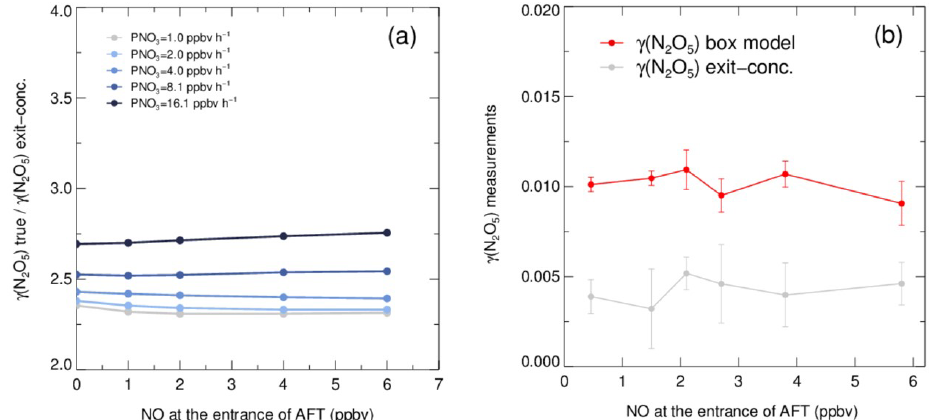
Figure 6. Simulated and laboratory tests on the performance of the box model method and exit concentration method for γ( N 2 O 5 ) derivation. (a) The ratios of given γ( N 2 O 5 ) ( γ( N 2 O 5 ) true) over exit concentration-derived γ( N 2 O 5 ) ( γ( N 2 O 5 ) exit conc.) determined from simulated scenarios. The γ( N 2 O 5 ) derived by the box model method is exactly the same as γ( N 2 O 5 ) true. The ratios vary with NO concentration, and the lines are color coded by PNO 3 values. Both NO concentration and PNO 3 represent the values at the entrance of the aerosol flow tube. (b) γ( N 2 O 5 ) measurements on laboratory-generated (NH 4 ) 2 SO 4 aerosols under different gradients of NO with a constant RH of 50% and PNO 3 typically generated from our N 2 O 5 source. The red line shows the γ( N 2 O 5 ) derived by the box model method, and the gray line shows the γ( N 2 O 5 ) derived by the exit concentration method. The NO concentrations are measured at the entrance of the aerosol flow